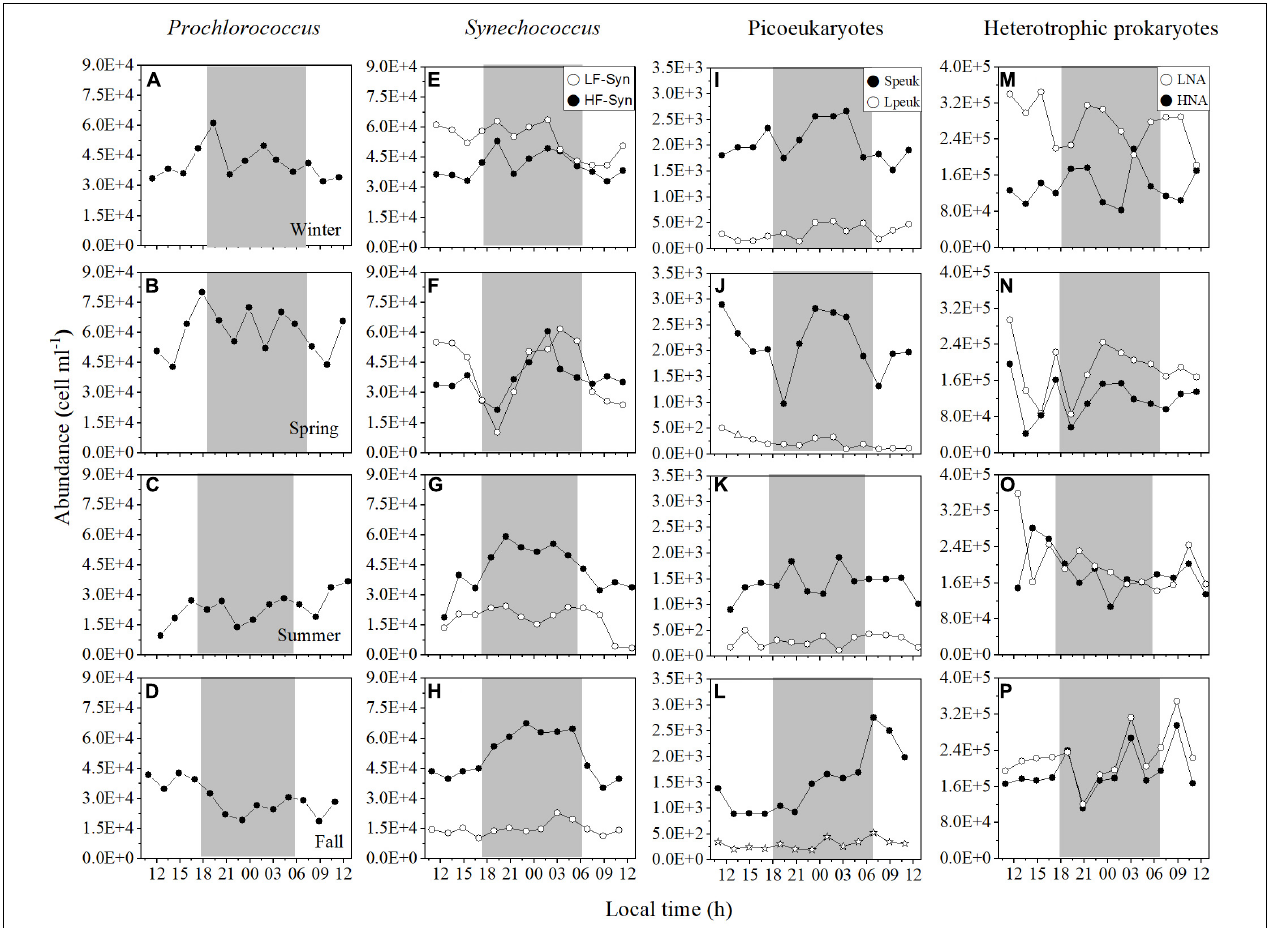
FIGURE 2 | Diel variation in picoplankton abundance at the surface of the study site in winter, spring, summer, and fall. Prochlorococcus (A–D) low (LF-Syn, open circles) and high (HF-Syn, filled circles) fluorescence Synechococcus (E–H) , small (Speuk, filled circles) and large (Lpeuk, open circles) picoeukaryotes (I–L) , low (LNA, open circles), and high (HNA, filled circles) nucleic acid content heterotrophic prokaryotes (M–P) . The gray shading represents nighttime.